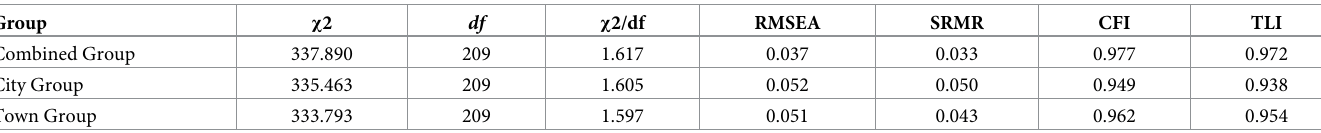
Table 4. Overall measurement model